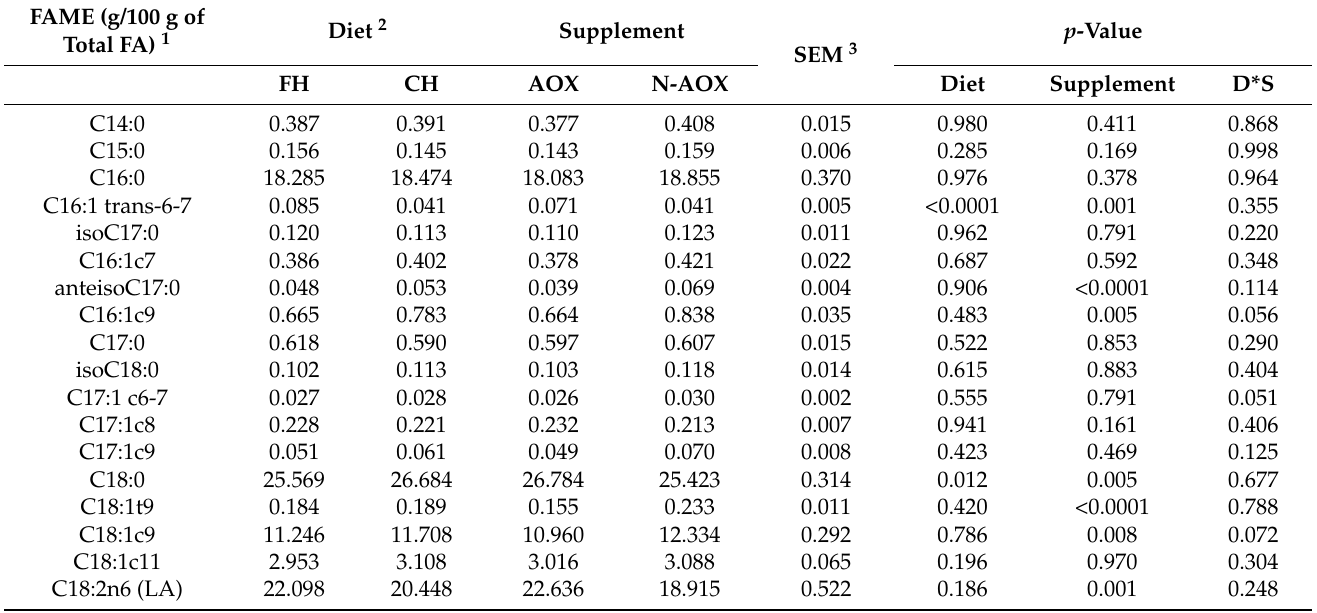
Table 4. Effect of different diets on fatty acid profile and nutritional indices of whole